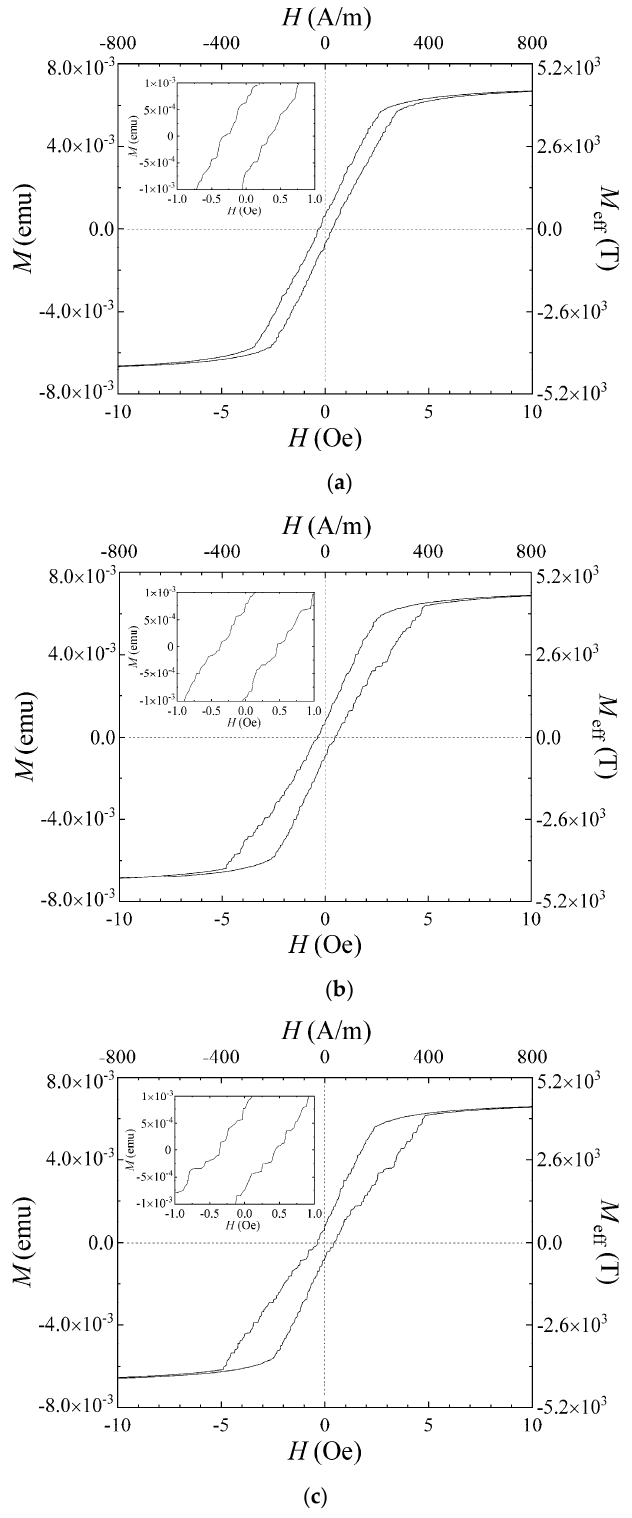
Figure 8. MH-loop of the fabricated elements. ( a ) The case for easy axis θ = 61 ° . ( b ) The case for easy axis θ = 71 ° . ( c ) The case for easy axis θ = 90 ° .